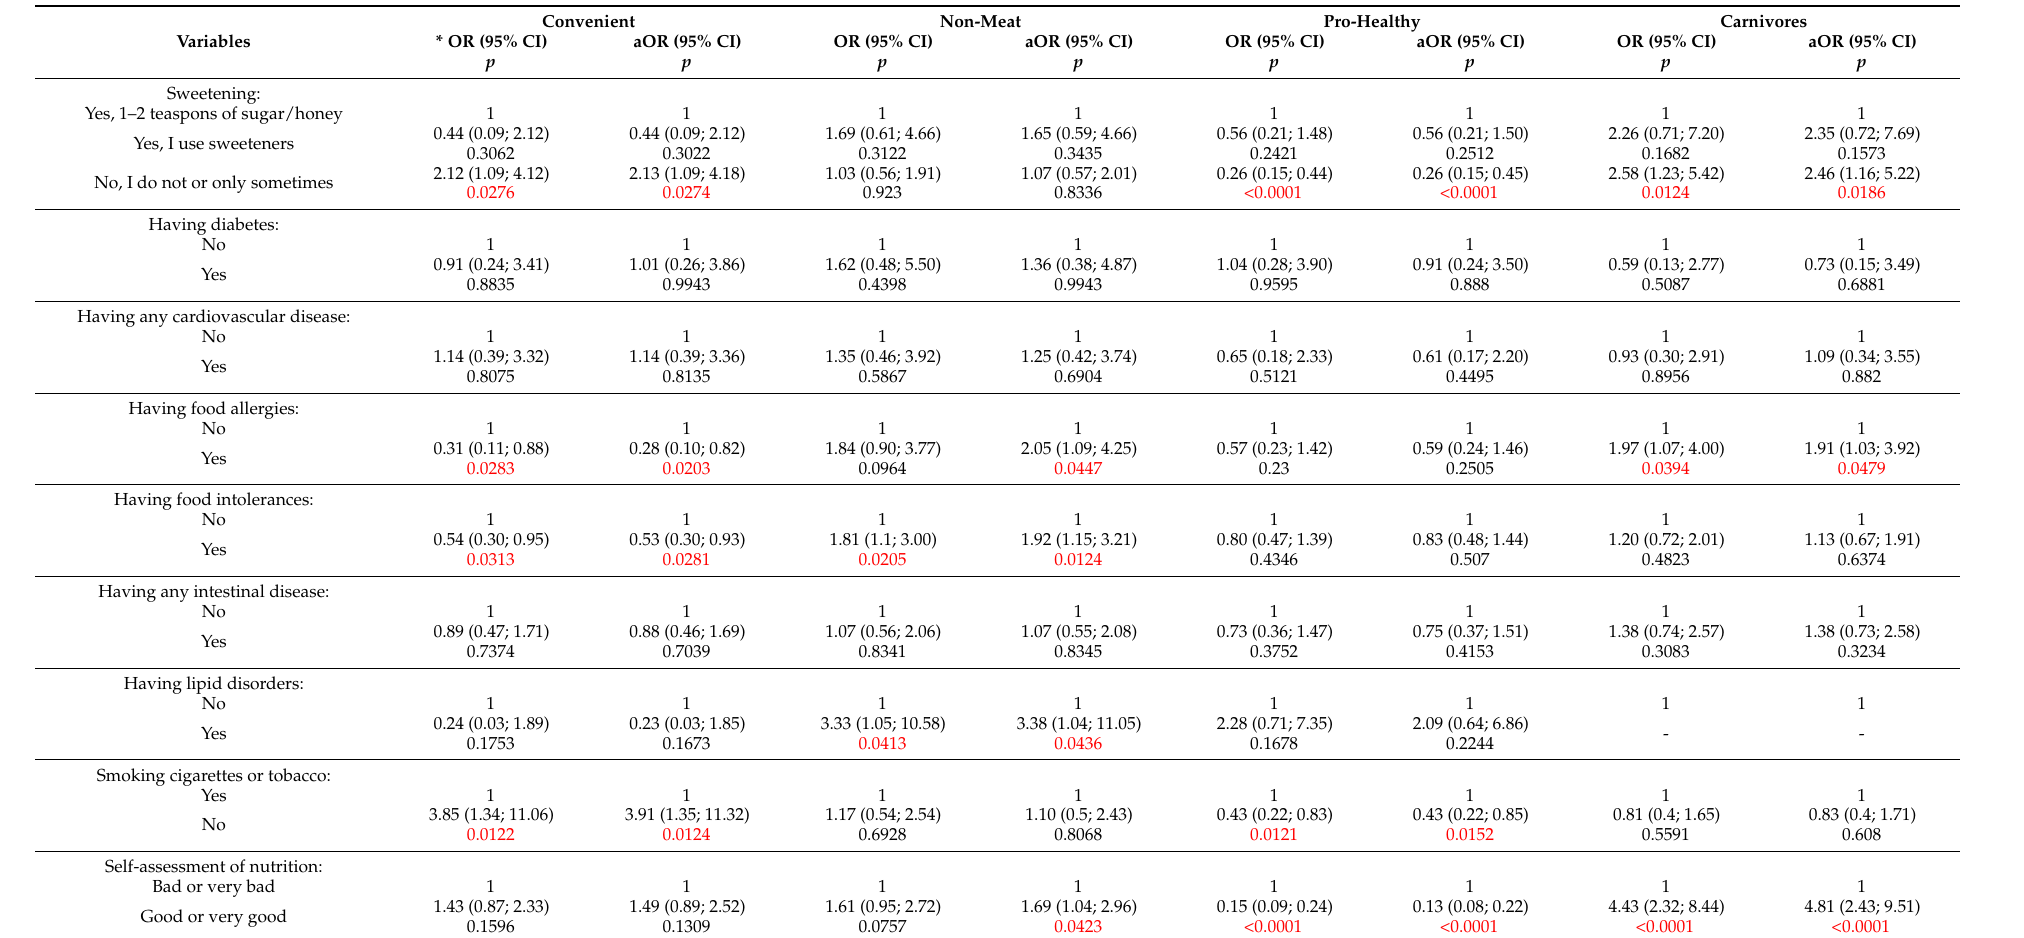
* OR—odds ratio, aOR—adjusted odds ratio. Red color—variable is statistically significant ( p <